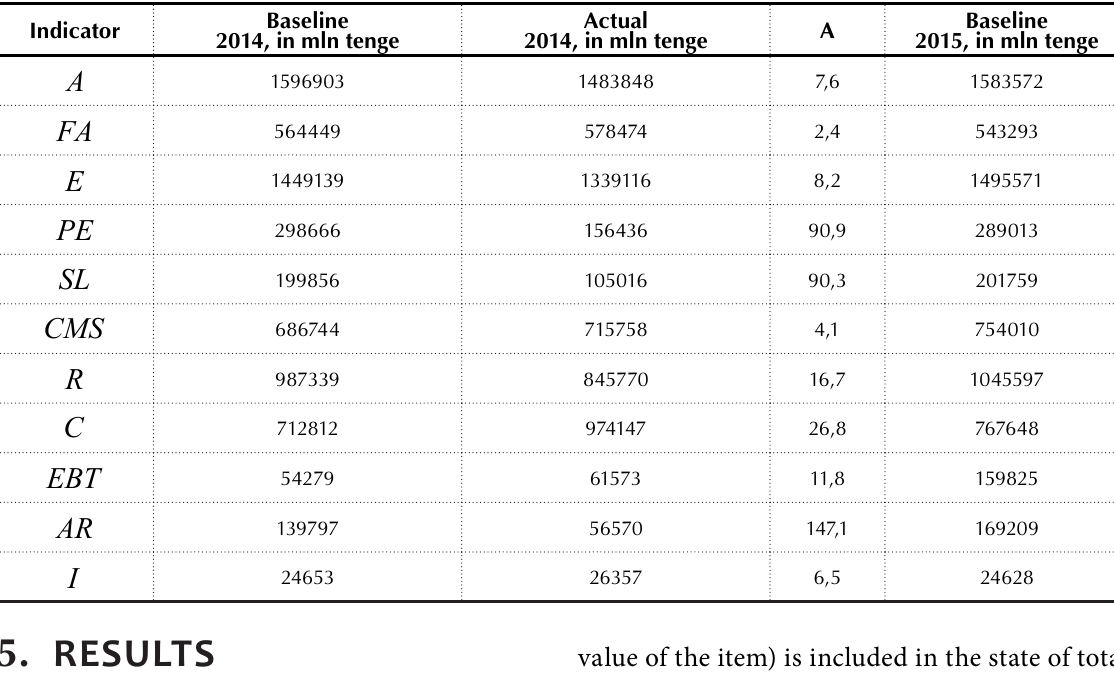
Table 1. Backtesting of the model adequacy